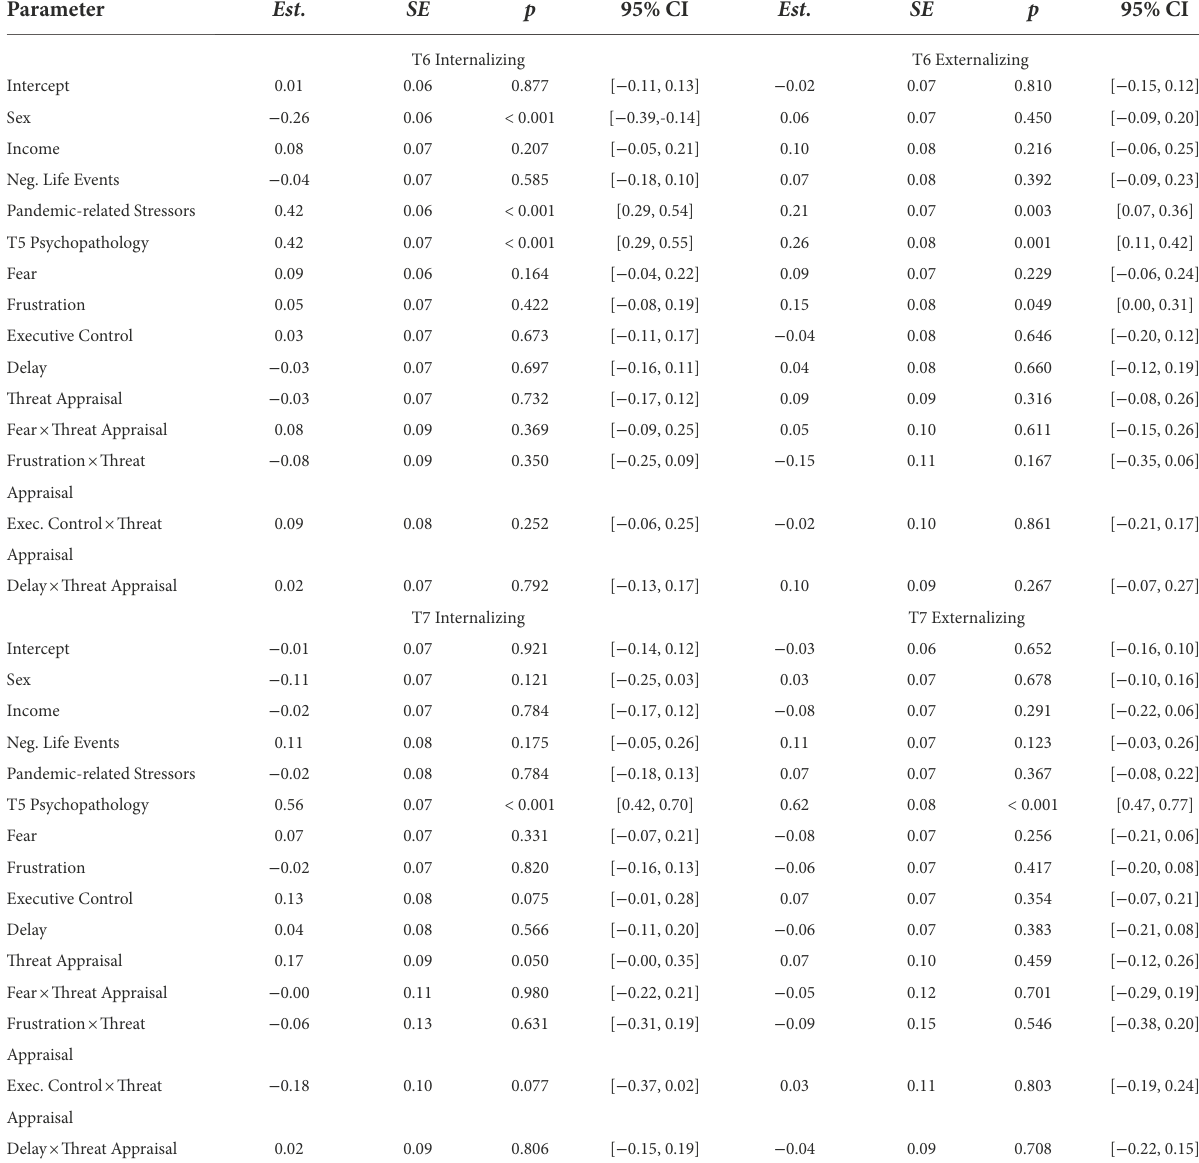
TABLE 6 Standardized regression coefficients, standard errors, and confidence intervals from regressions predicting adolescent psychopathology from temperament and threat appraisal.